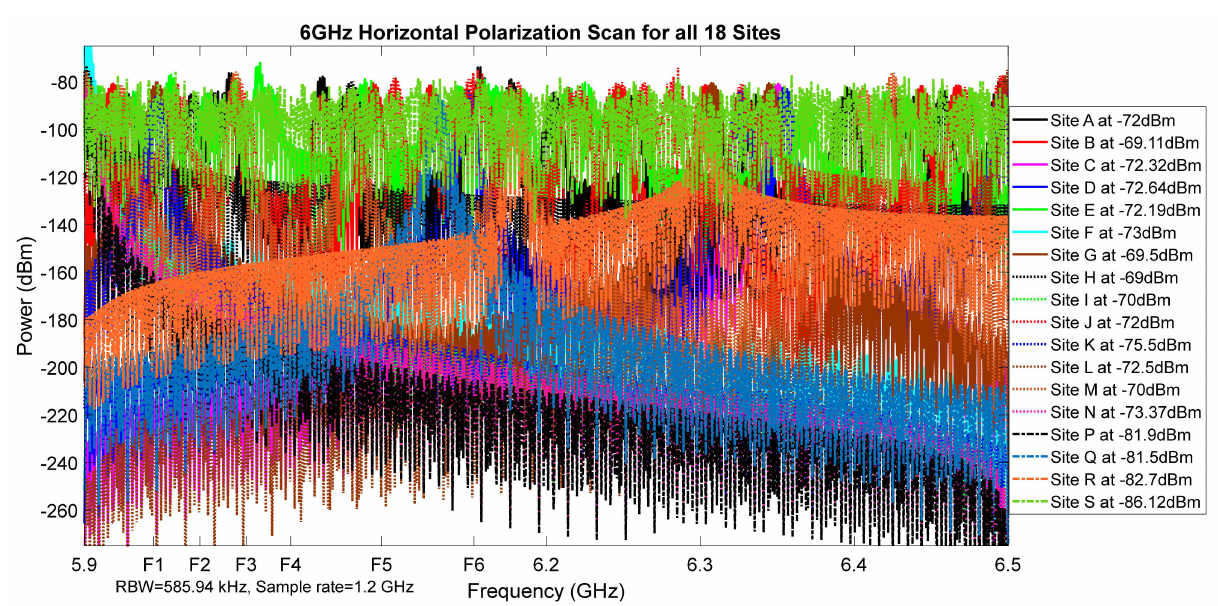
Figure 41. The 6 GHz horizontal polarization scan for all sites after denoising and applying the algorithm to all sites, including those without the potential to cause